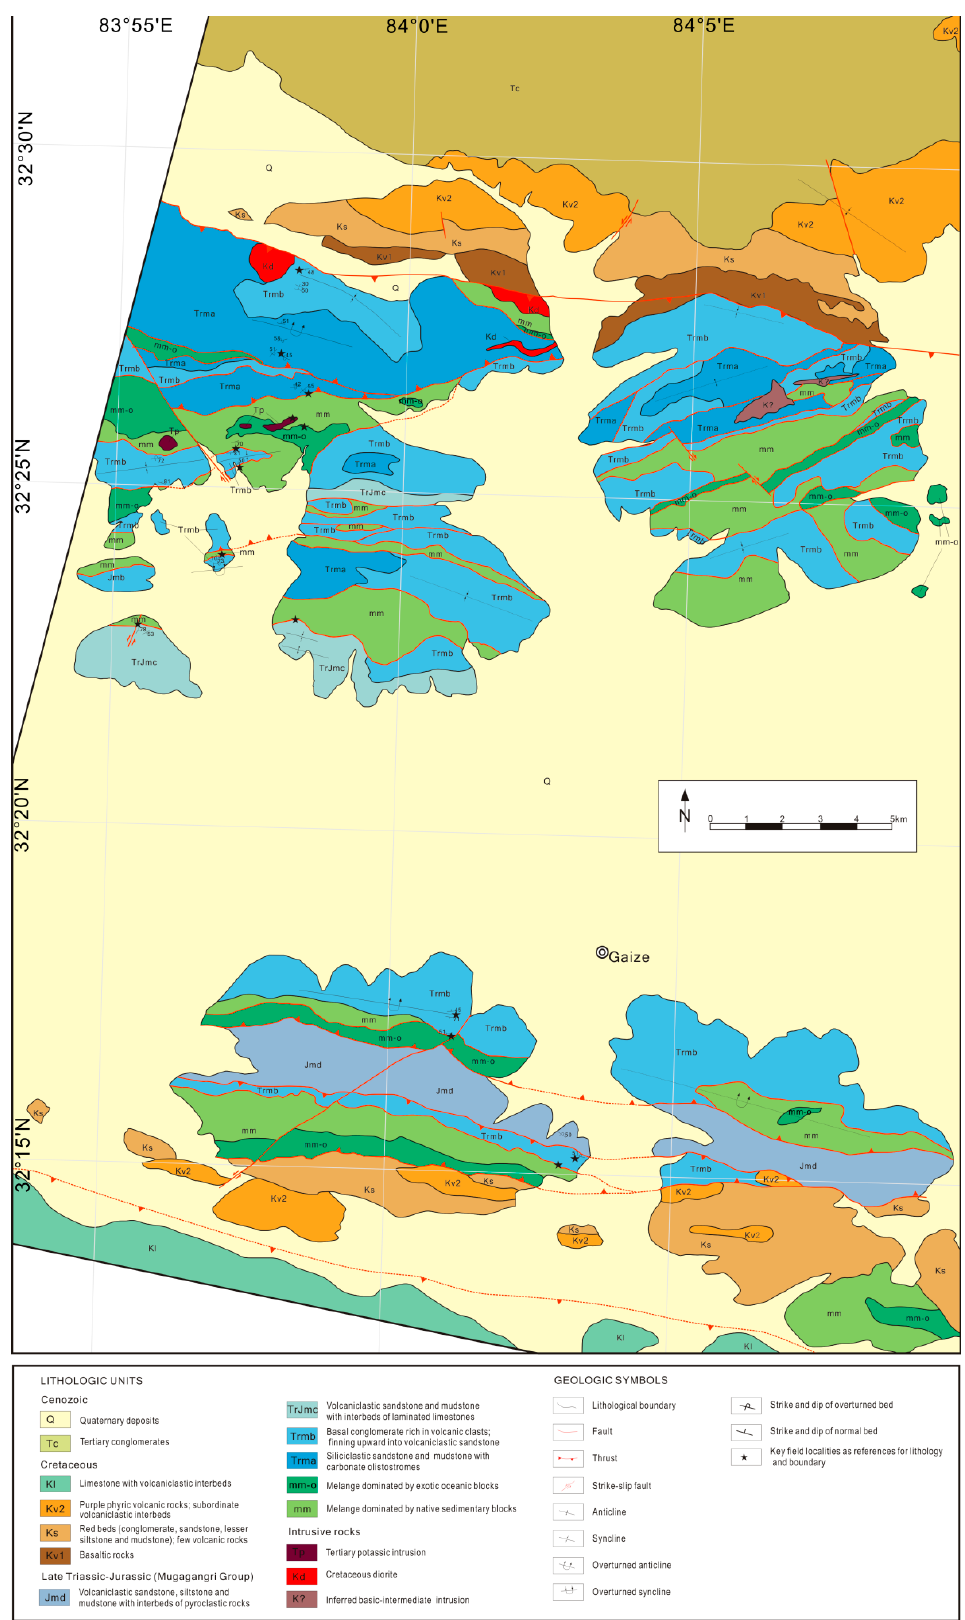
Figure 13. New lithologic map of the study area generated based on the combined analyses of field and ASTER data.